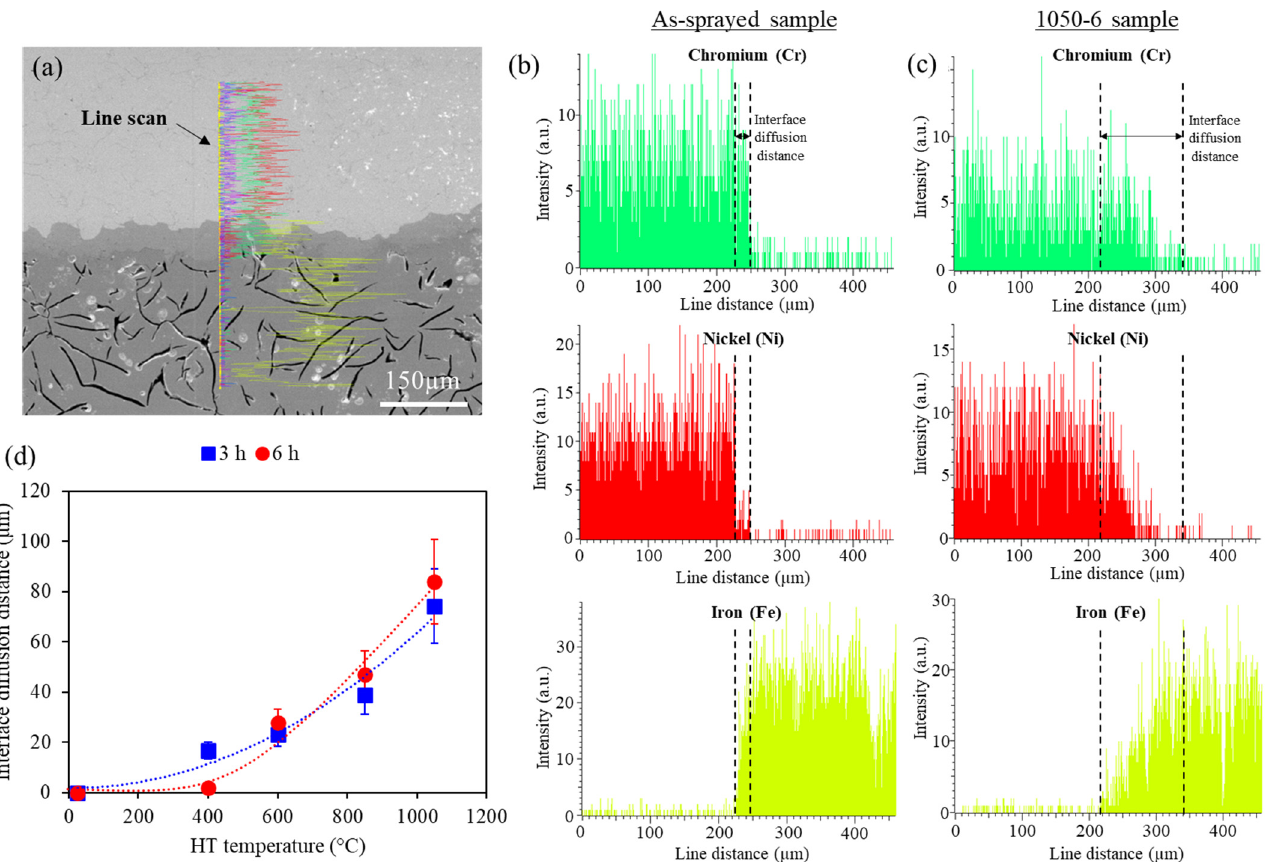
Figure 6. ( a ) SEM of 600-6 sample with the line scan location (representative sample), Elemental composition from a line scan for ( b ) as-sprayed and ( c ) 1050-6 sample, and ( d ) Interface diffusion distance at varying temperatures with 3 and 6 h hold durations.